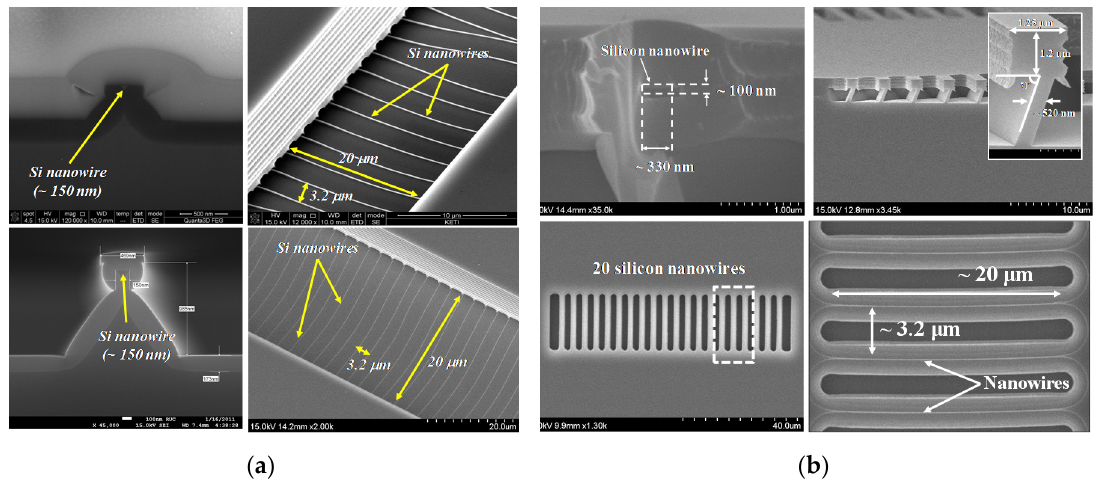
Figure 1. Previously reported silicon-nanowire array fabricated by top-down processes. ( a ) (100) silicon-nanowire array [5] (Reproduced with permission from Lee et al ., Sensors and Materials; published by MY K.K., 2012); ( b ) (111) silicon-nanowire array [6] (Reproduced with permission from Lee et al ., Journal of Micromechanics and Microengineering; published by IOP Publishing 2014).